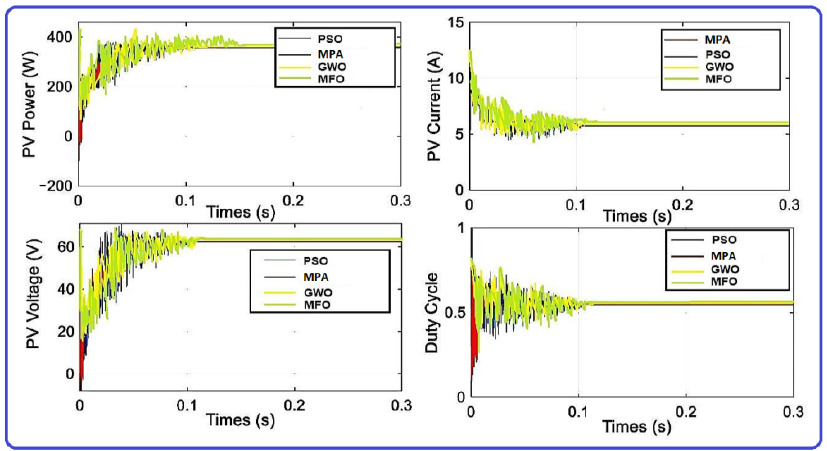
Figure 10. Duty along with PV power, current, voltage for MPA, PSO, GWO and MFO during case 4.